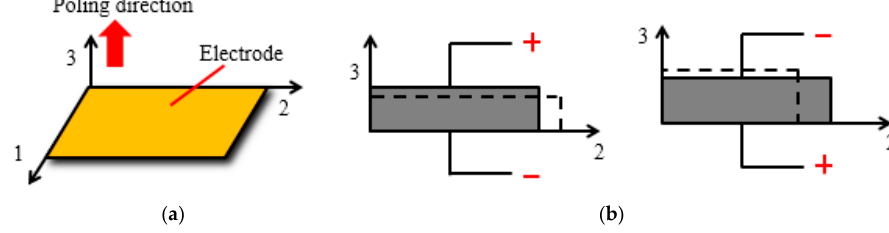
Figure 3. Schematic of PZT patch with compressive mode: ( a ) 3D view; ( b ) Front view.